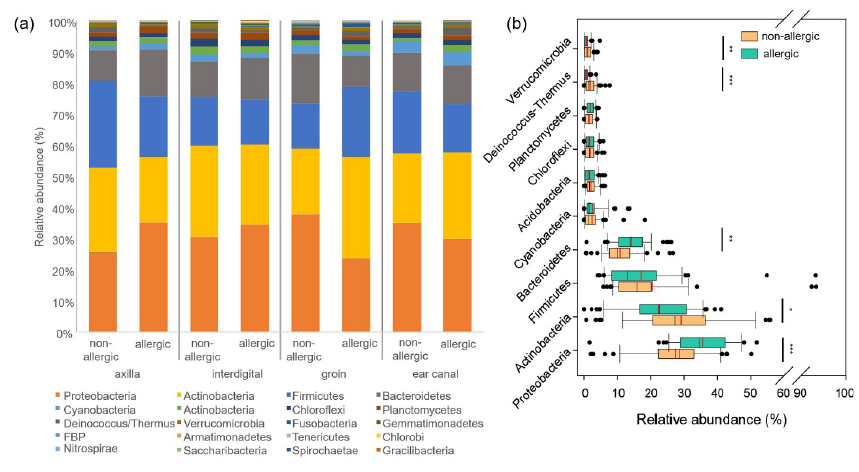
Fig 3. Phylogenetic composition of the skin (axilla, interdigital, groin) and ear canal microbiota of non-allergic (n = 12) versus allergic (n = 12) GSDs resolved at the phylum level. (a) Mean relative abundances of bacterial phyla identified in axilla, interdigital, groin and ear canal of non-allergic and allergic dogs. (b) Variation of the relative abundances (across all body sites) of the 10 most abundant phyla among non-allergic and allergic dogs. Asterisks are representing statistical significance: � p < 0.05; �� p < 0.01; ��� p < 0.001.